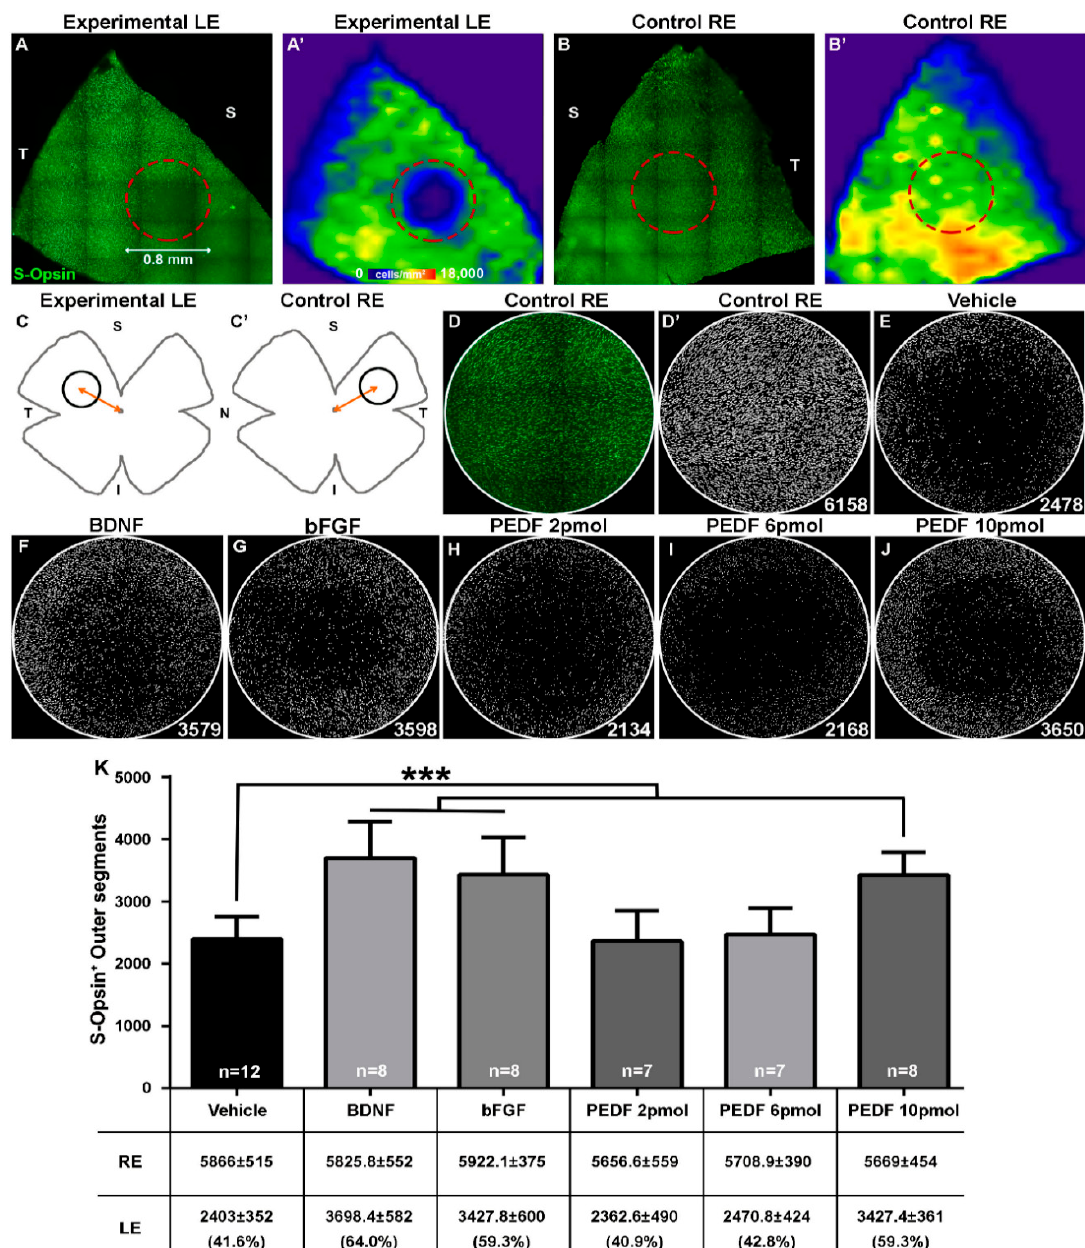
Figure 1. PEDF (pigment epithelium-derived factor) protection of S-cones against LIP (Light Emitting Diode-Induced Phototoxicity)-induced damage. Photomontages of supratemporal retinal quadrants and their corresponding isodensity maps in an experimental retina (left eye) exposed to LIP ( A , A’ ) and its fellow-contralateral retina (right eye) ( B , B’ ) immunostained with an antibody to detect S-opsin OS. The predetermined fixed-size circular area (PFA) involving the retinal damage resulting from LED exposure is outlined by a dotted red circle (diameter of 0.8 mm) on the left retina ( A , A’ ) and its corresponding region on the right retina ( B , B’ ). ( C , C’ ) depict the location of the PFA for